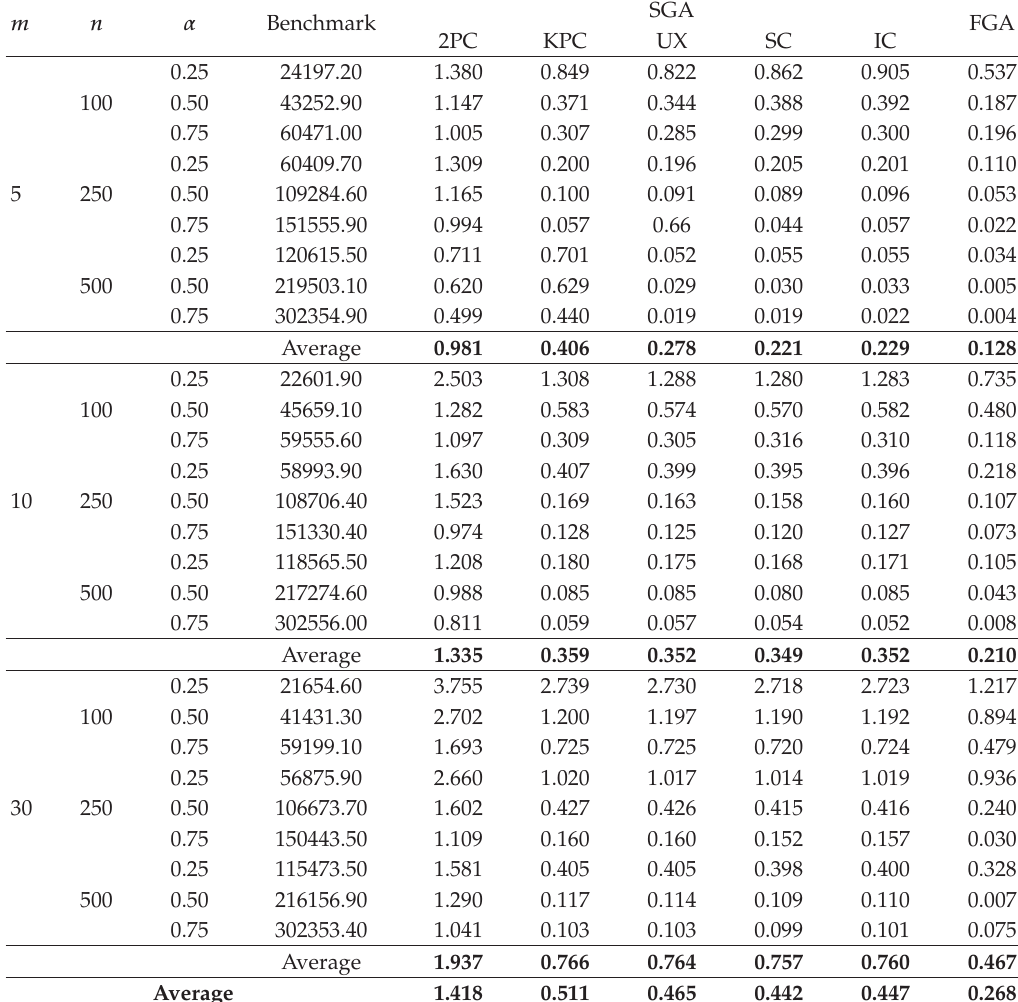
Table 7: Comparative computational results (cid:3) 20 CPU seconds per run (cid:4)